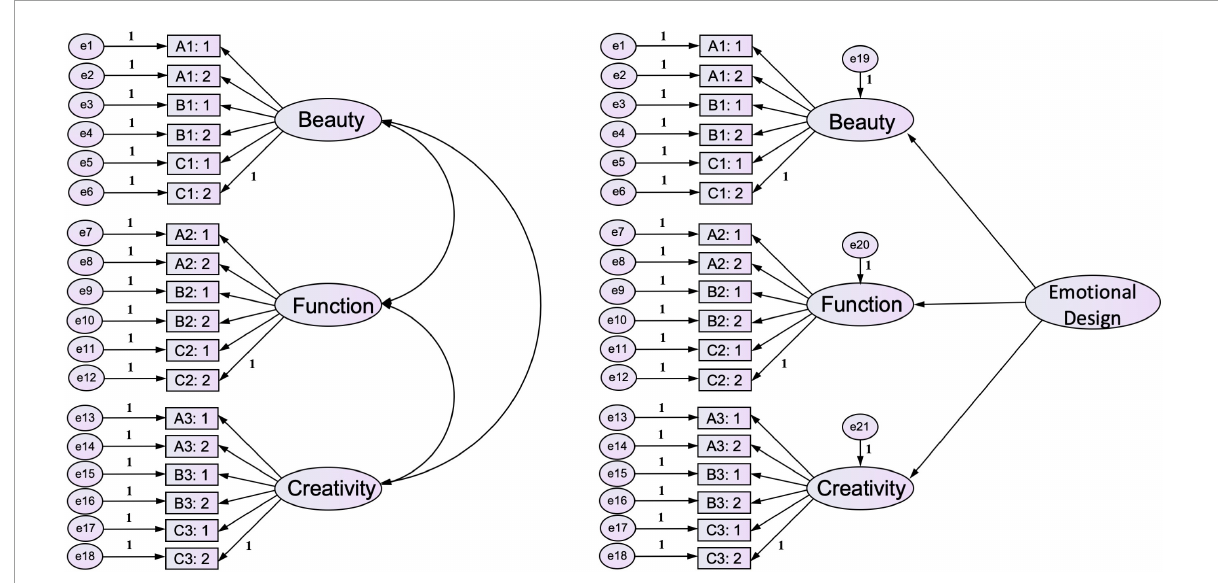
FIGURE3 First-order three-factor model (There are correlates among these factors) and second-order factor